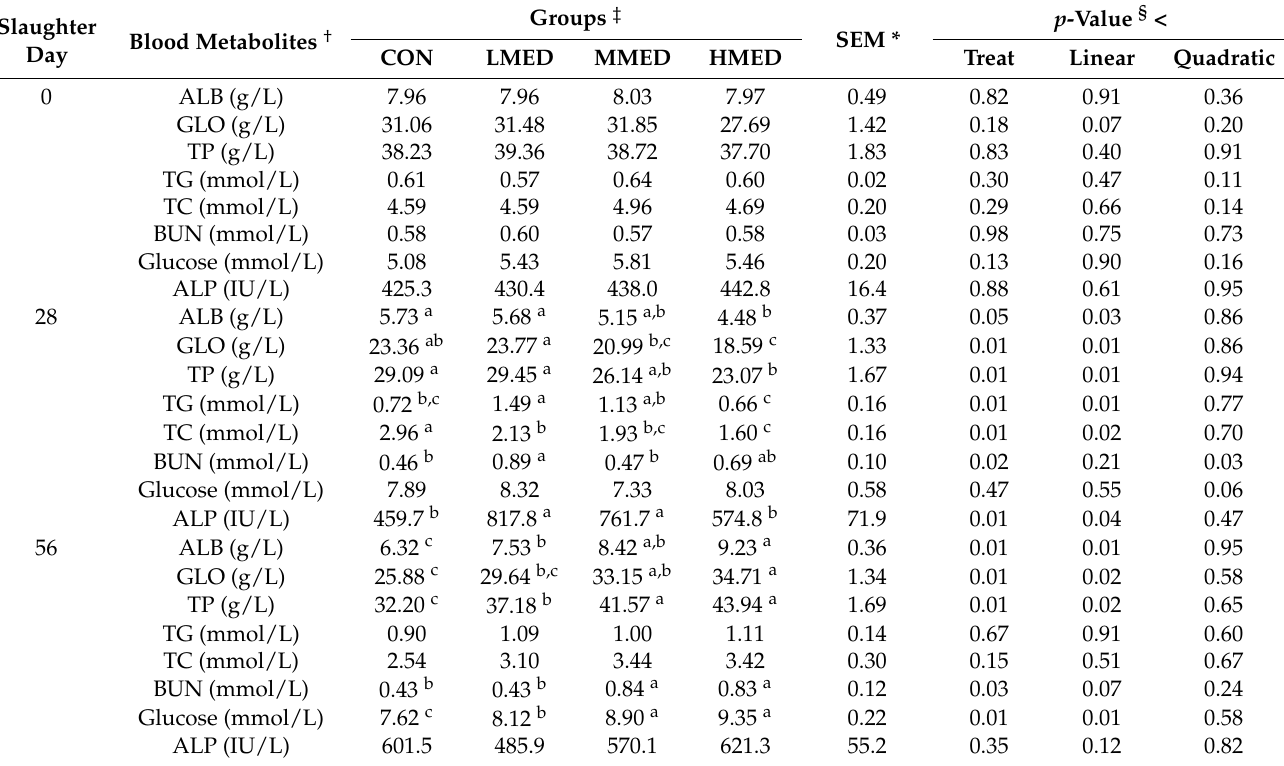
Table 8. Effects of supplemental feeding diets with three levels of metabolizable energy (ME) on serum blood biochemical parameters of grazing